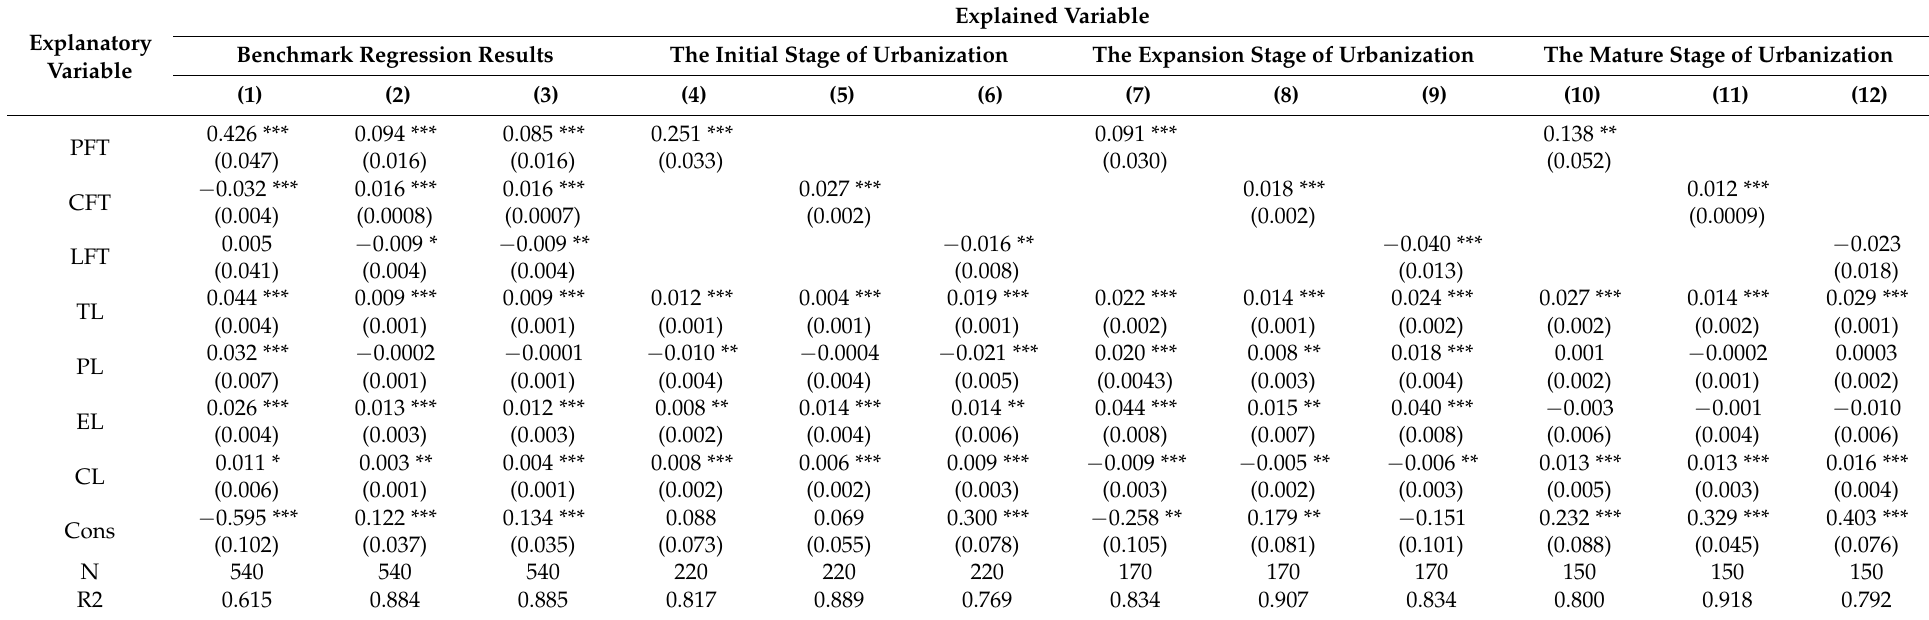
Table 5. Regression analysis of impact factors of